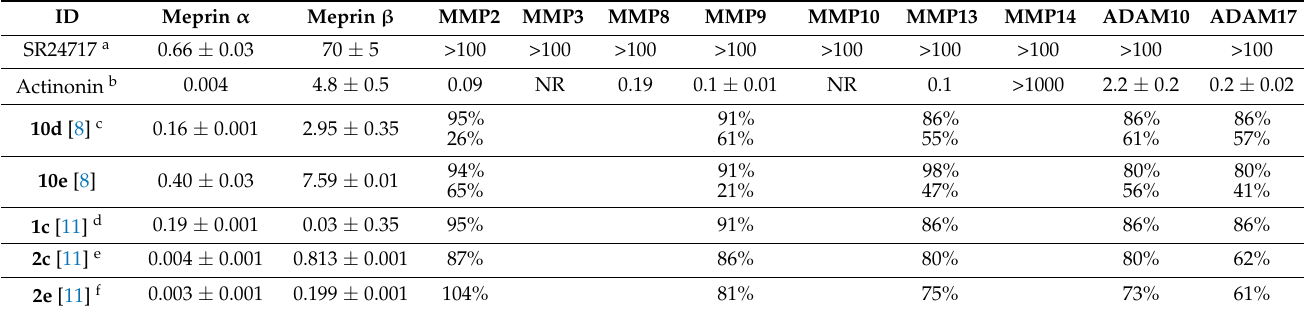
Table 3. Selectivity testing of SR24717 and literature meprin α inhibitors.